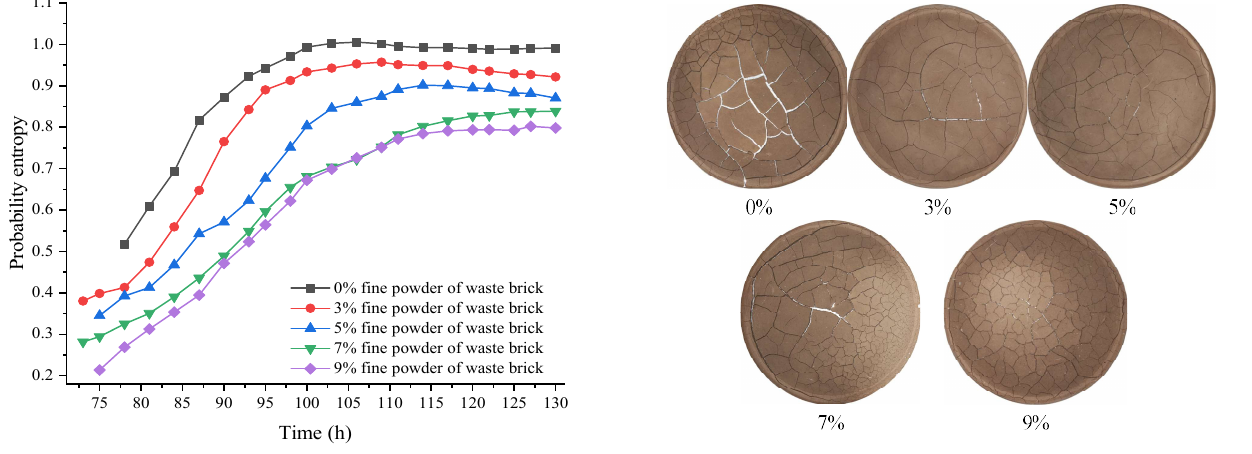
Figure 5. Probability entropy changing over time and development characteristics of cracks of soil samples with different contents of added recycled waste brick micro-powder (pictures taken at the same time).